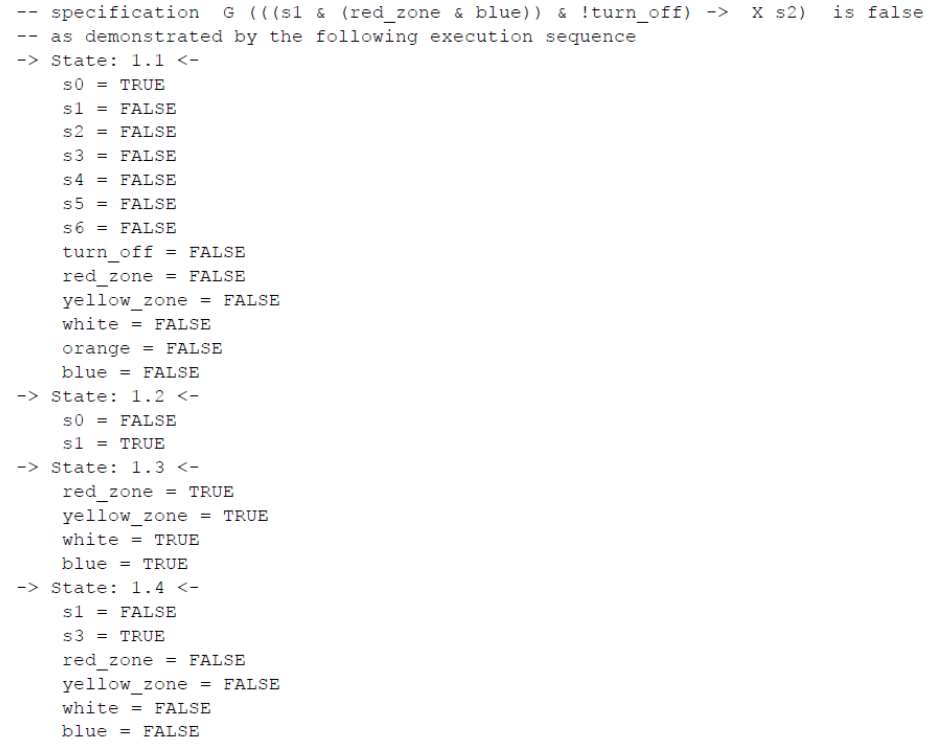
Figure 10. Generated counterexamples for changing into the safety production mode with a white uniform in the yellow zone leading to alarm mode.